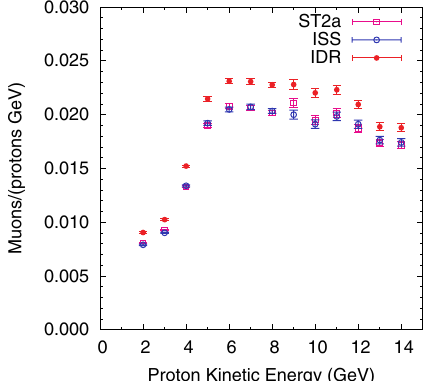
FIG. 13. Muon transmission through the NF front end channel as computed by ICOOL , starting from meson distributions at the downstream end of the target ( Z ¼ 0 cm